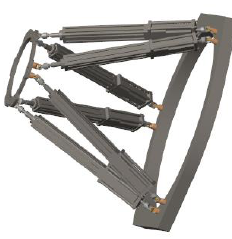
Figure 13. Robot model constructed by SimMechanics.